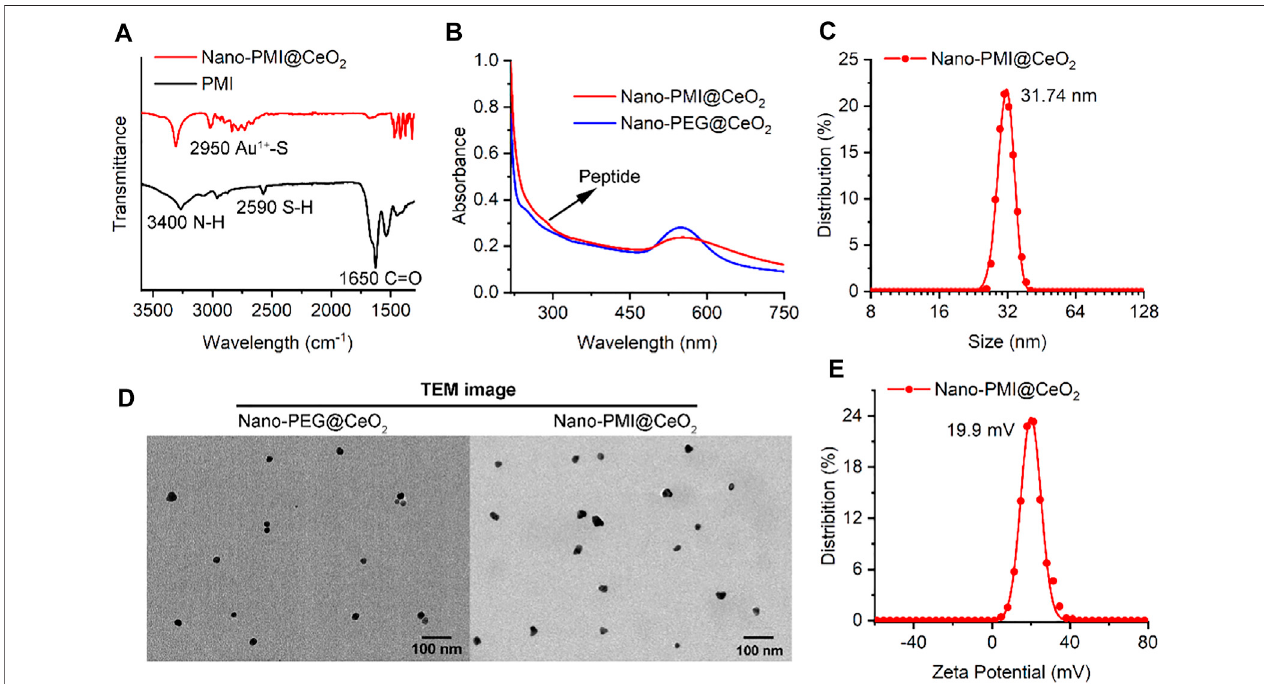
FIGURE 2 | Characterization of Nano-PMI@CeO 2 . (A) FT-IR spectroscopy of Nano-PMI@CeO 2 and PMI. Two absorption peaks at 3400 cm − 1 and 1650 cm − 1 were distributed to the stretching vibration of N-H and C=O of peptides. (B) UV – Vis spectra of peptides Nano-PMI@CeO 2 and Nano-PEG@CeO 2 . The typical Au nano shell absorption peak was observed closely at 550 nm. (C) Surface charge (Zeta potential) of Nano-PMI@CeO 2 was measured in PBS at pH 7.4. (D) TEM images of